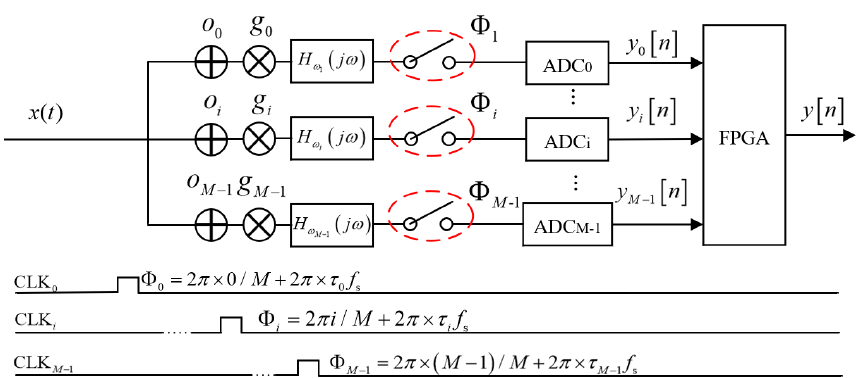
Figure 1. Conceptual graph of an M ‐ channel time ‐ interleaved analog ‐ to ‐ digital conversion system.